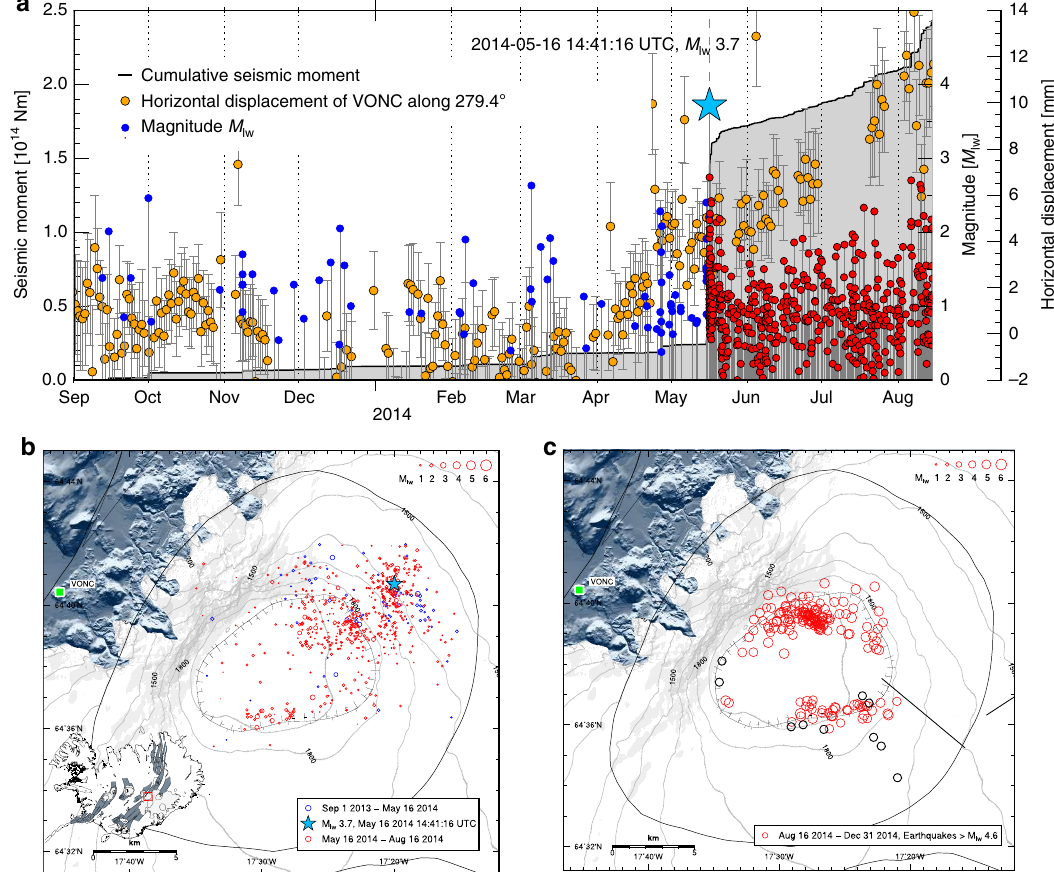
Fig. 1 Seismicity and deformation at Bárðarbunga. a Earthquakes versus time (1 September 2013 – 15 August 2014; before diking and eruption) plotted as impulses scaled with magnitude (right axis). Earthquakes prior to M3.7 event on 16 May 2014 shown in blue and red afterwards. Also shown is cumulative seismic moment (shaded in grey; left axis), and horizontal displacement in direction N279.4°E (yellow dots) at GPS-station VONC from detrended time series (Supplementary Fig. 1). Error bars ( 1 σ ) in grey. b Inferred location of the earthquakes (Methods) shown in a , with earthquakes prior to M3.7 event on 16 May 2014 shown in blue and red afterwards. Small map of Iceland shows the study area outlined with a red box, fi ssure swarms 76 with grey shading, and oval outlines showing central volcanoes and calderas 76 . c Location of M > 4.6 earthquakes during the caldera collapse (Methods). Note aseismic segments of the caldera. Background map shows shaded surface (grey) and Vatnajökull icecap (white) topography from the ArcticDEM database 77 , and outlines of the Bárðarbunga central volcano (oval shape) and its caldera 42 . Straight lines show segments of the lateral dike that formed and black open circles are ice cauldrons 5